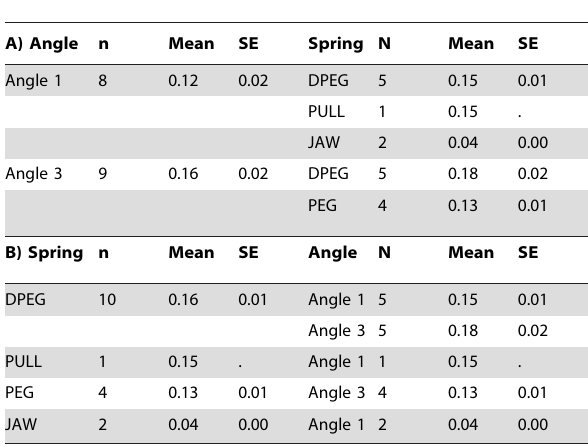
Table 2. Mean values and standard errors of impact momentum (Ns) among rat trap types*.